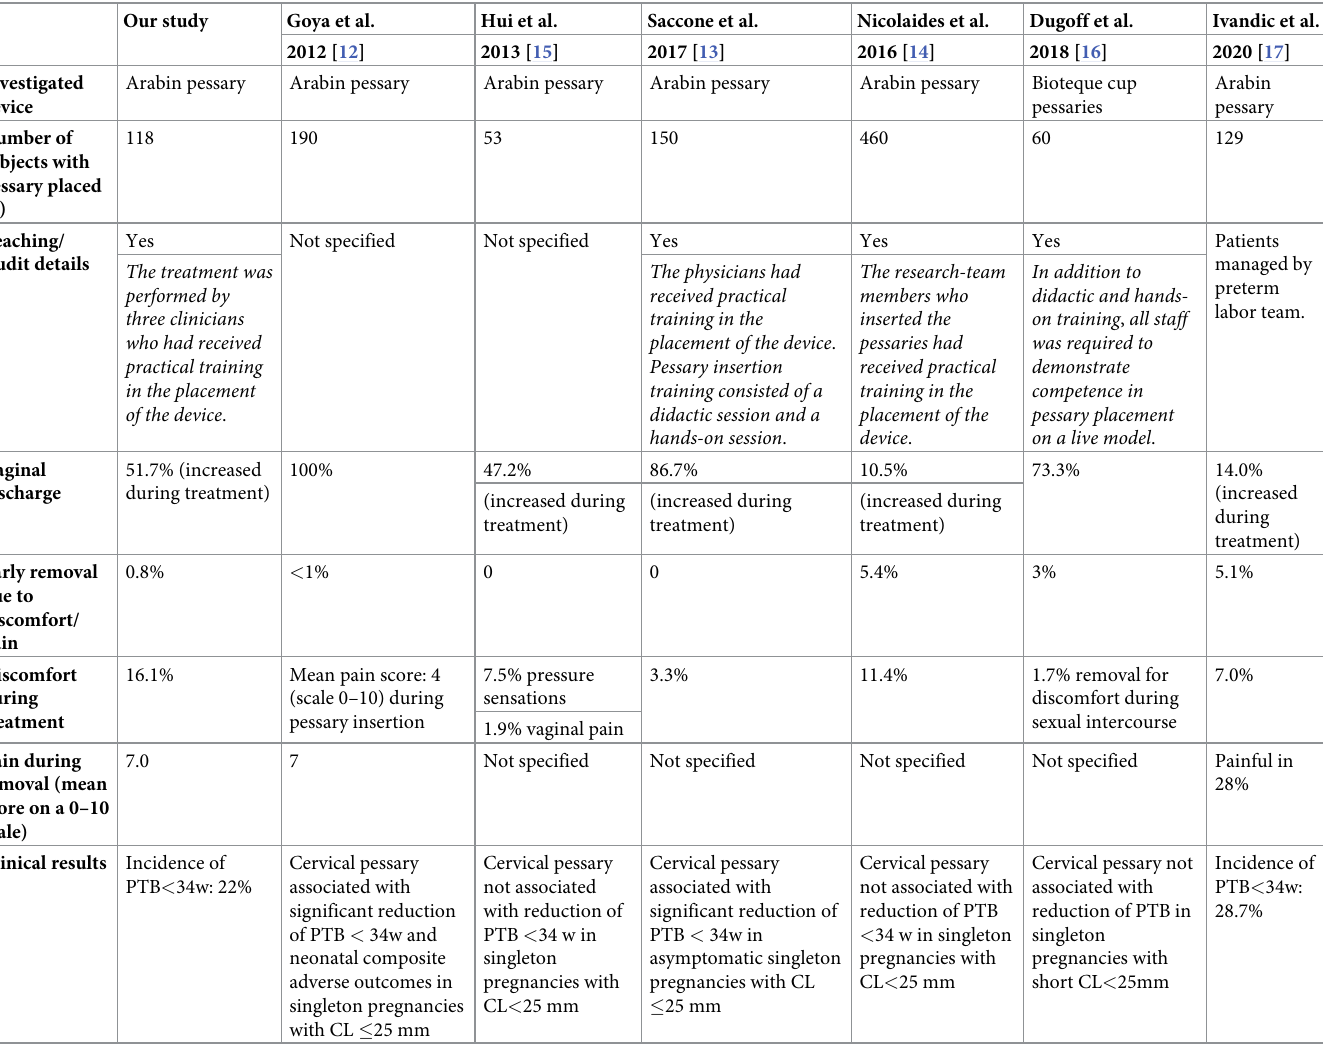
Table 4. Comparison between studies on pessary use in singleton gestations in terms of side effects, experience and training of clinicians, and clinical